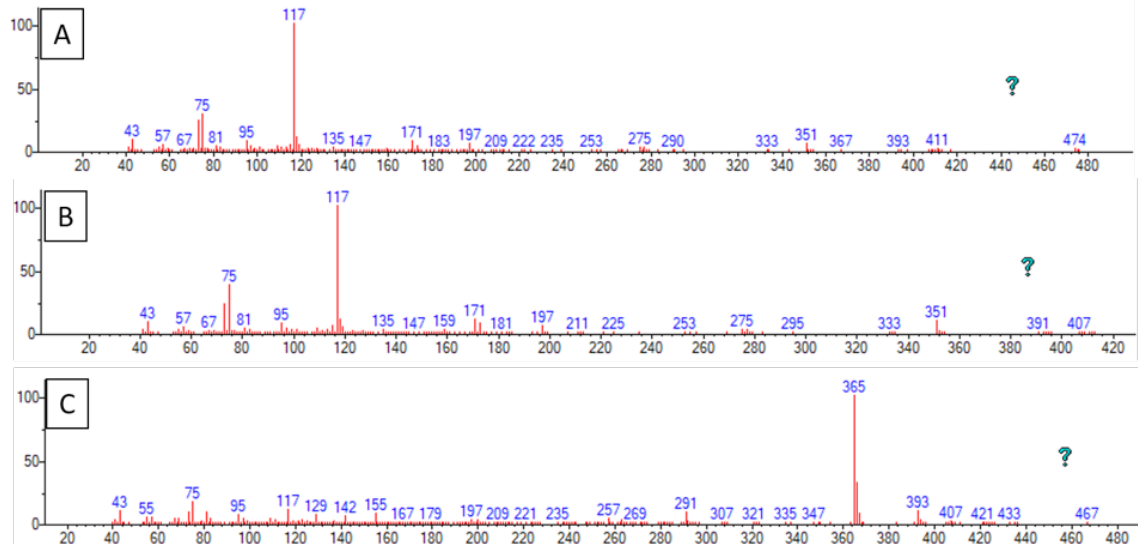
Fig 4 . Mass spectra of the unidentified compounds. A) unknown 1, RT = 55.44 min; B) unknown 2, RT = 56.405 min; C) unknown 3, RT = 60.85